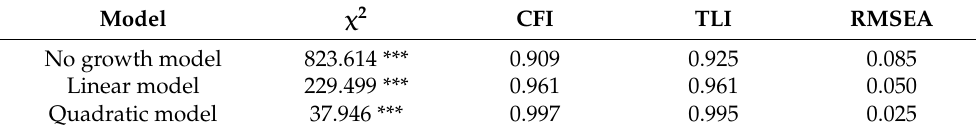
Table 3. Model fit for Latent Growth Model for Depression Change.